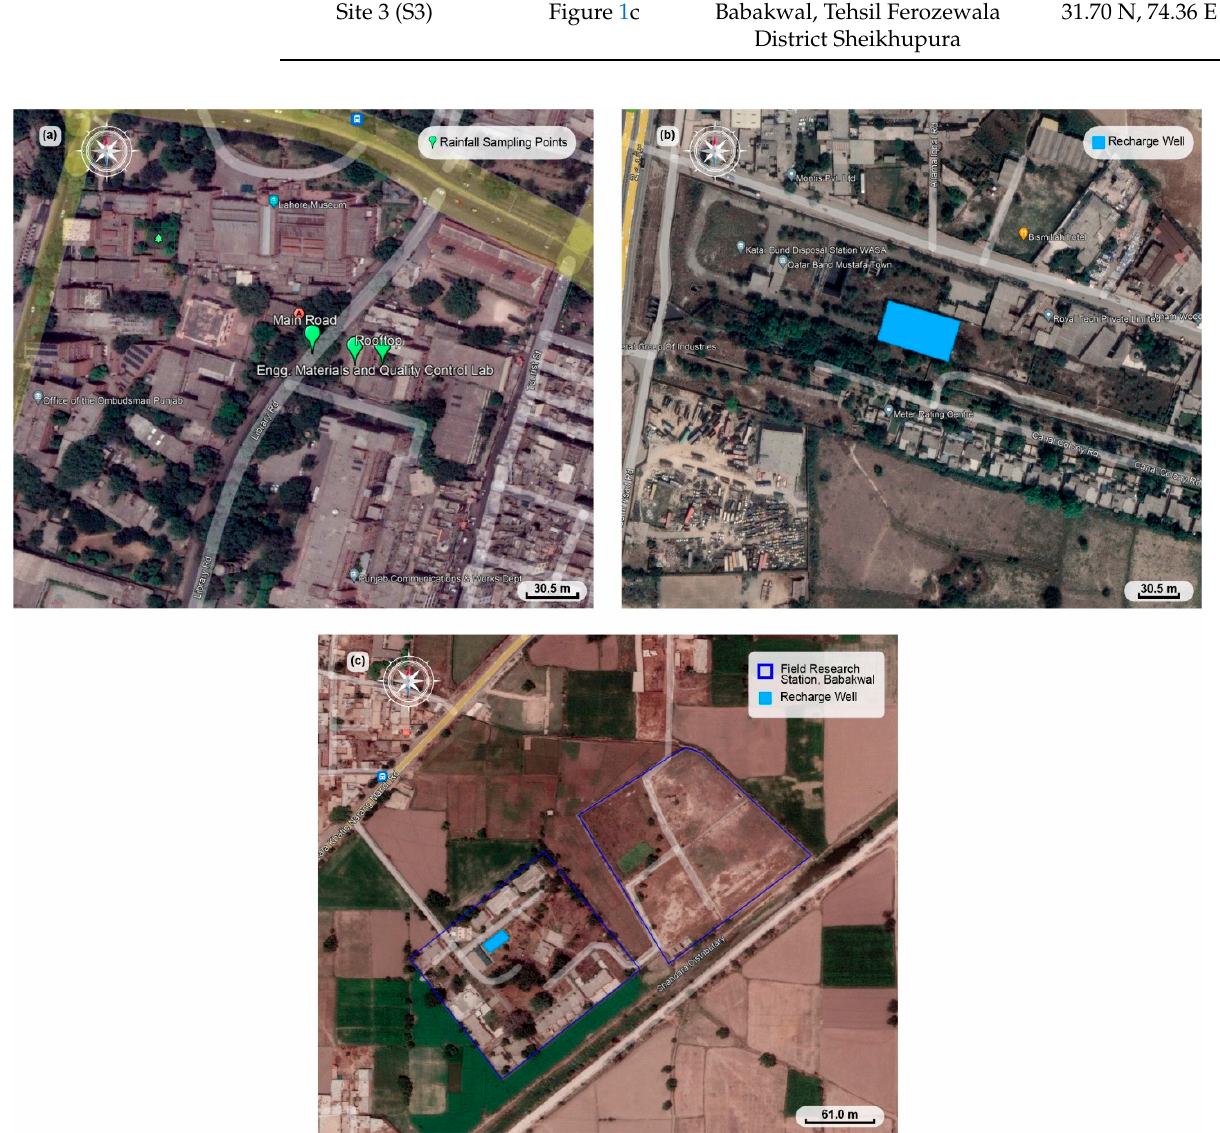
Figure 1. Map of the study sites ( a ) S1—Irrigation Research Institute, Lahore, ( b )